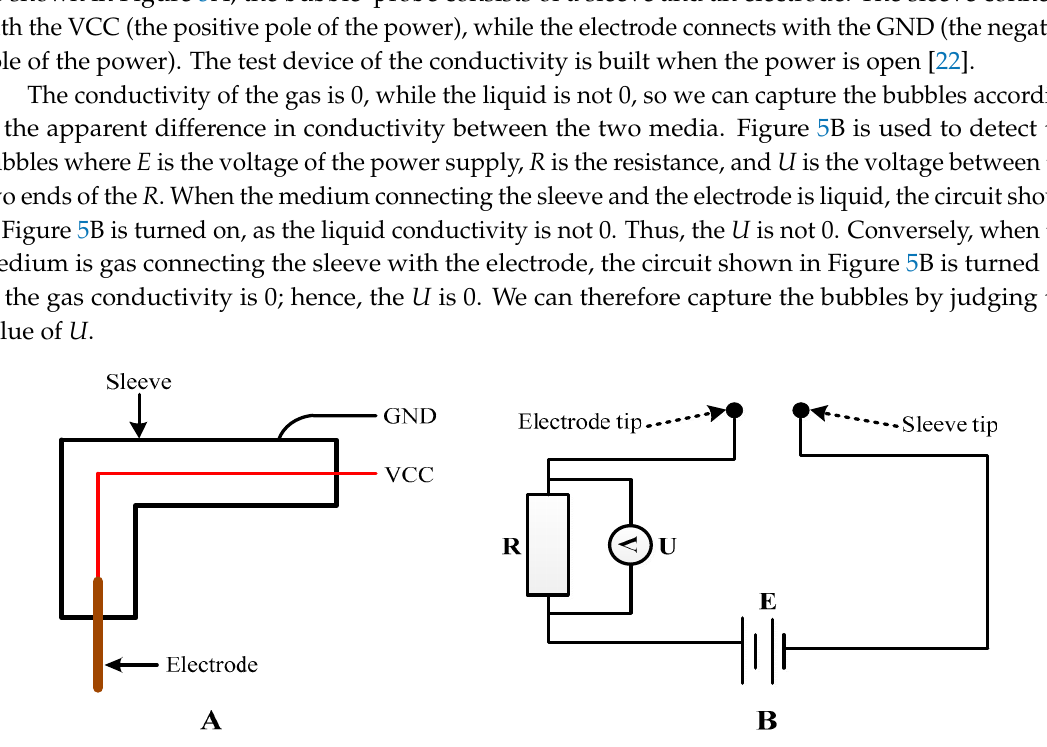
Figure 5. Detection principle of the bubble probe. ( A ): the elementary structure of the bubble probe; ( B ): the data process circuit of the bubble